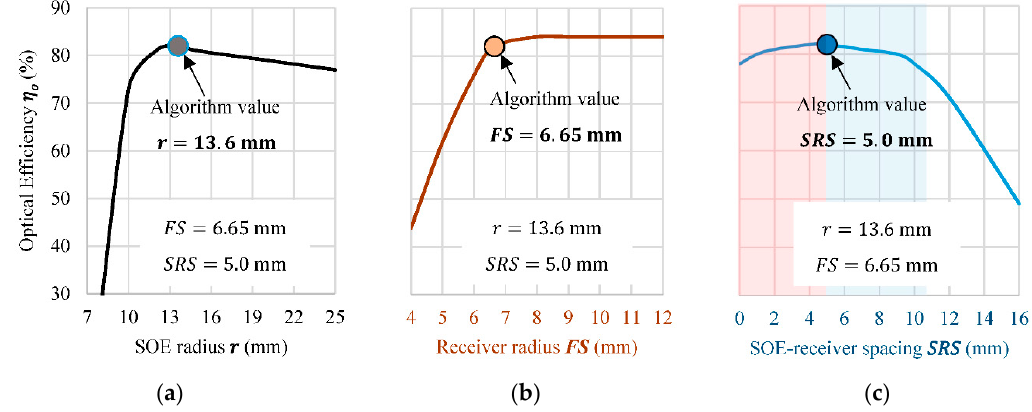
Figure 7. Case 1 concentrator optical efficiencies at an incidence angle of 1.0° for the iterated parameters (optimum values from the algorithm are enlarged in each curve) of ( a ) SOE radius, 𝑟 , in mm, ( b ) receiver radius, 𝐹𝑆 , in mm, and ( c ) SOE–receiver spacing, 𝑆𝑅𝑆 , in mm (shaded areas: left—higher concentration, right—better homogeneity).